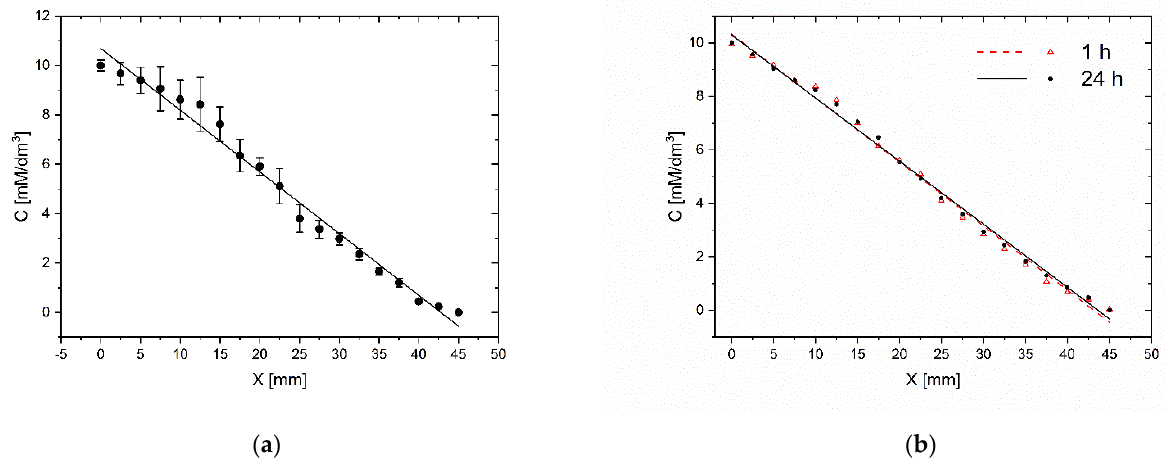
Figure 7. Evaluation of the gradient repeatability ( a ) and the gradient stability in time ( b ) C–methylene blue concentration, X–distance from the beginning of the workspace of CC. Evaluation immediately after establishment and after 24 h.